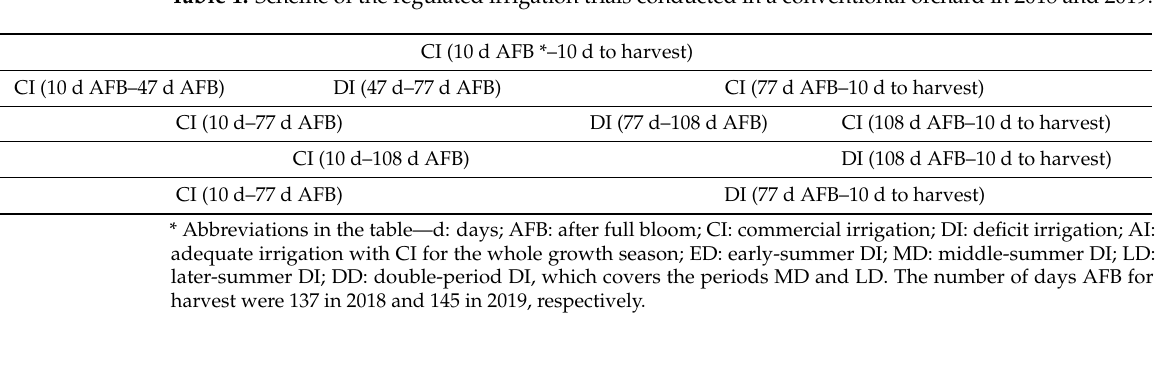
Table 1. Scheme of the regulated irrigation trials conducted in a conventional orchard in 2018 and 2019.